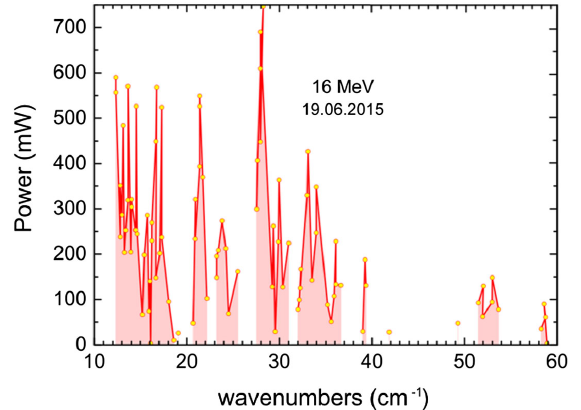
FIG. 1. Output laser power vs. wavelength, measured on FLARE at 16 MeV.